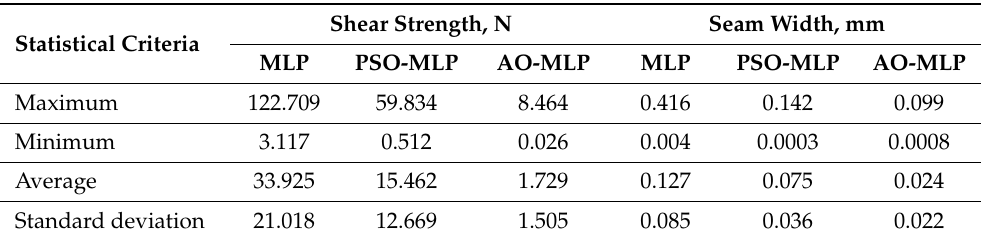
Table 3. Statistical analysis of absolute errors between predicted data using MLP, PSO-MLP, and AO-MLP and target ones.